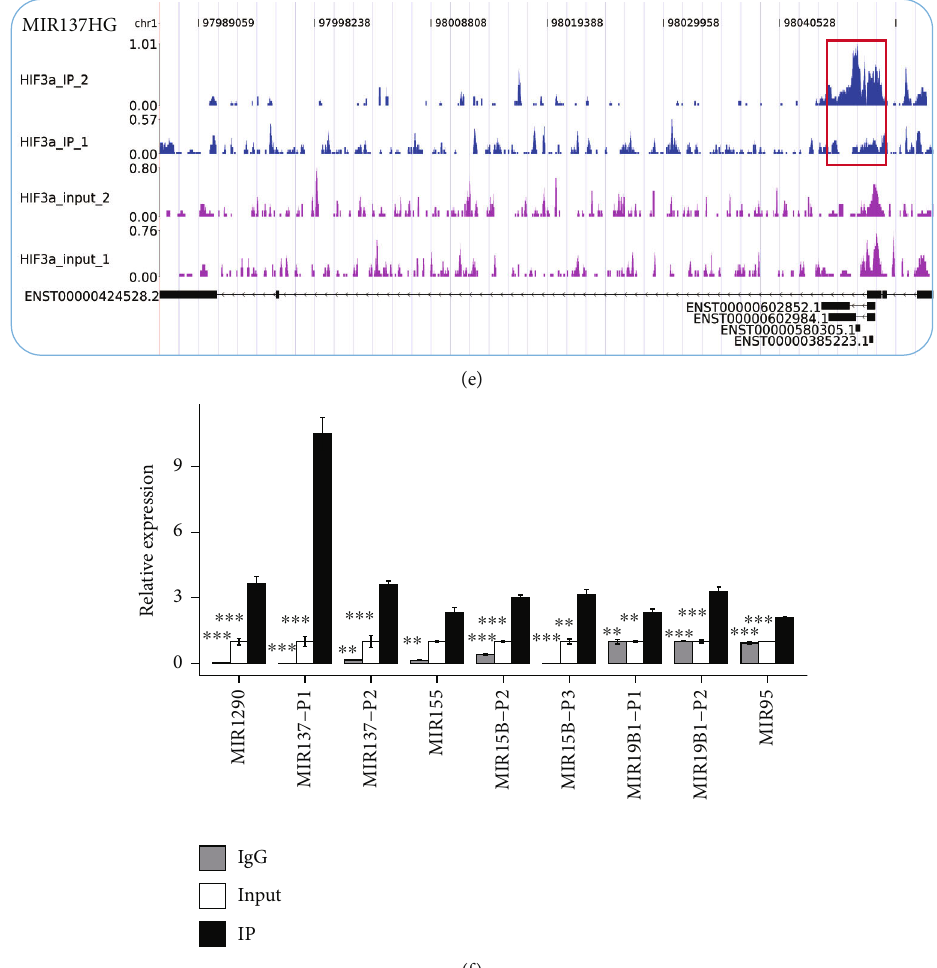
Figure 3: ChIP-seq results of HIF-3 α showed its binding preference at promoter region. (a) Read density heat map plot showed the enriched read distribution around gene TSS sites. (b) Pie chart showed the percentage of peaks from four genomic regions. (c) Bar plot showed the percentage of bound genes classi fi ed by their coding types. The white and brown bars represent two biological replicates of HIF-3 α ChIP-seq data. (d) Venn diagram showed HIF-3 α -bound genes and HIF-3 α -regulated DEGs. (e) Read distribution of bound miRNA miR-137. Red rectangle represents the bound region of HIF-3 α . (f) Bar plot showed the validation results of ChIP-qPCR